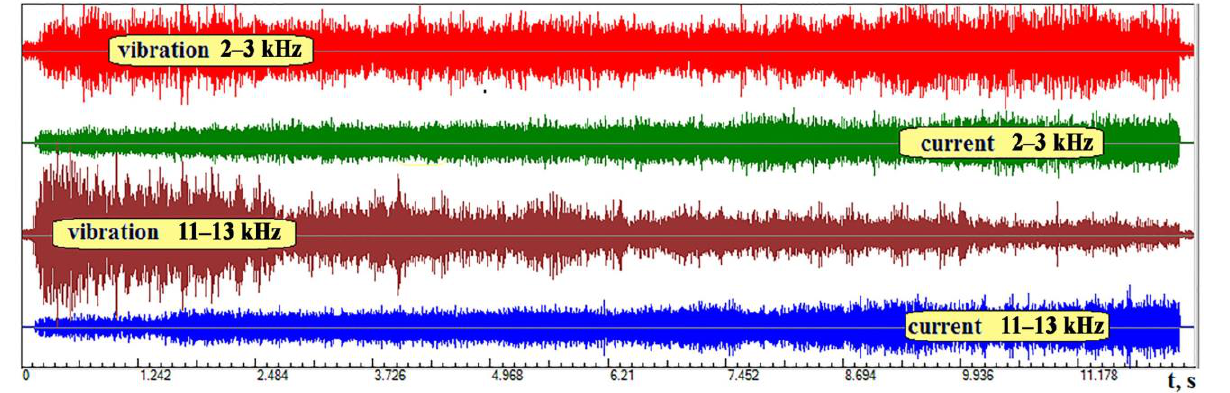
Figure 7. Recording of AE signals and discharge current in the ranges of 2 – 3 kHz (upper graphs) and 11 – 13 kHz (lower graphs) during WEDM of hard alloy HG012 from the moment of embedding to the break of the wire electrode.